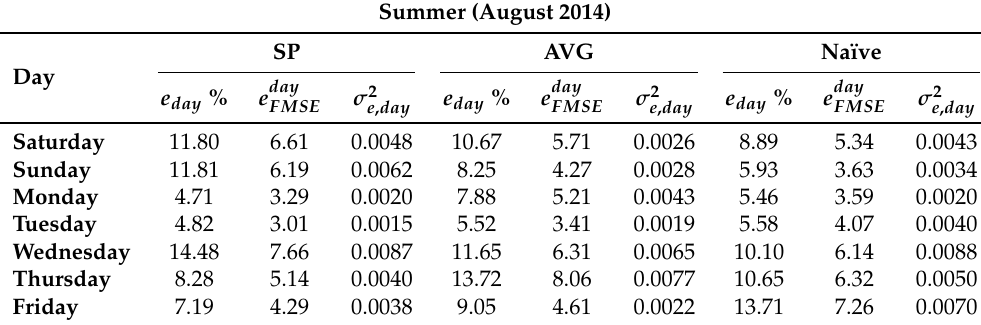
and σ 2 of autumn of 2016, 2015 and 2014 for the SP model, average FMSE e , day